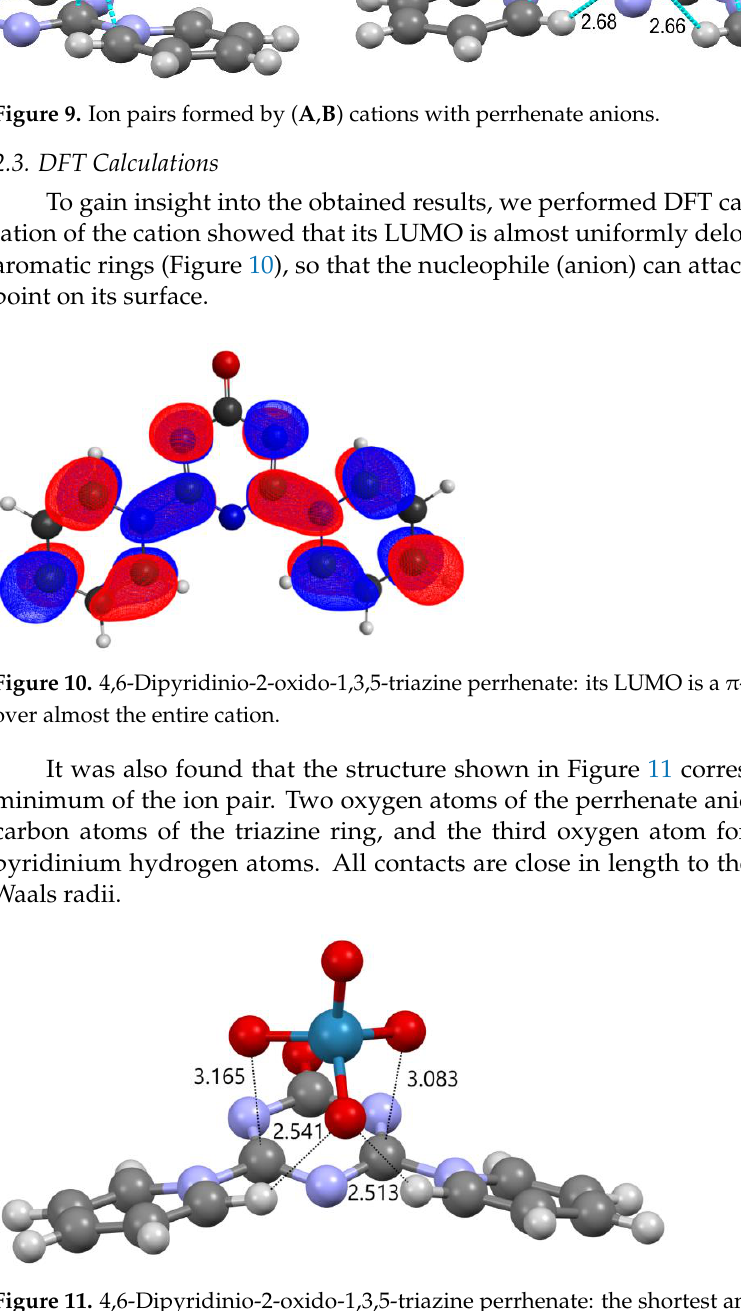
Figure 11. 4,6-Dipyridinio-2-oxido-1,3,5-triazine perrhenate: the shortest anion – cation contacts (Å ) are indicated by dotted